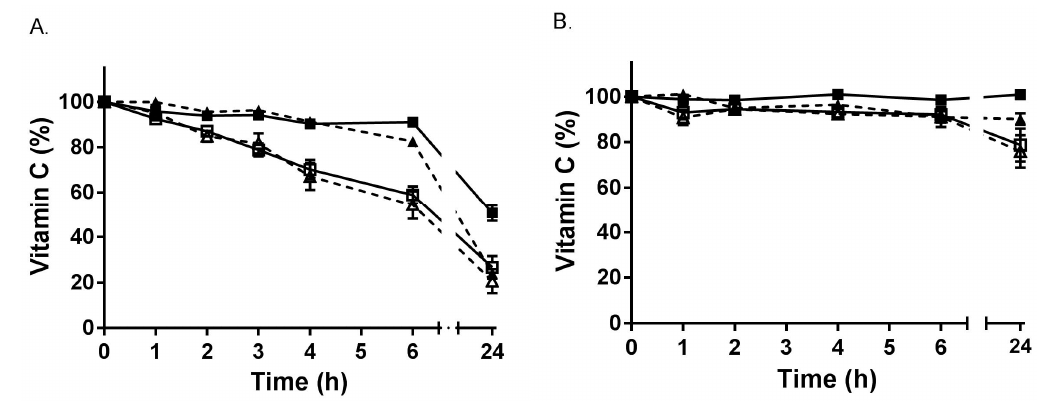
Figure 2. Stability of vitamin C in whole blood. ( A ) EDTA-blood was incubated on ice ( (cid:4) , (cid:78) ) or at room temperature ( (cid:3) , (cid:52) ). ( B ) Heparin-blood was incubated on ice ( (cid:4) , (cid:78) ) or at room temperature ( (cid:3) , (cid:52) ). Samples without TCEP reduction are shown with dashed lines, and those with TCEP using solid lines. Samples were extracted for ascorbate HPLC analysis at the indicated time points. Data represent the mean ± SEM ( n = 3). Repeated measure one-way ANOVA with Dunnett’s test for multiple comparison indicated no significant decrease in ascorbate in EDTA-blood on ice over 6 h ( p = 0.153), but a significant decrease in ascorbate at room temperature from 2 h ( p = 0.046). There was no significant decrease in ascorbate in heparin-blood on ice for 24 h ( p = 0.182), or at room temperature over 6 h ( p = 0.163).